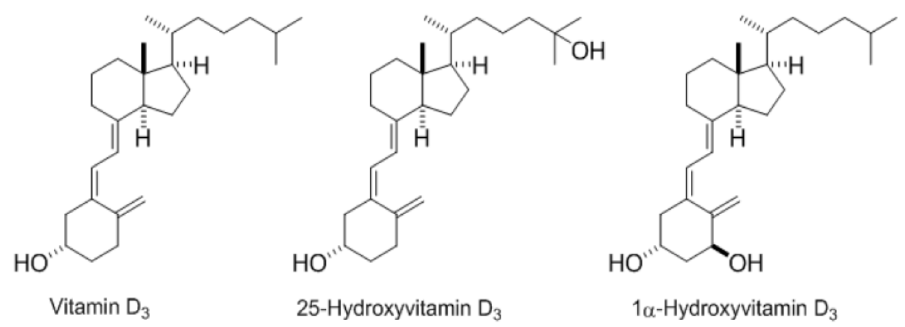
Figure 1. Vitamin D 3